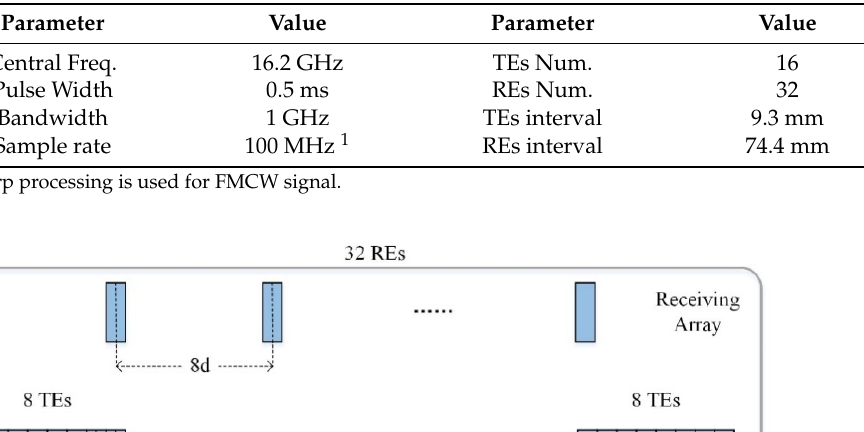
Table 1. System parameters for MIMO radar simulation.